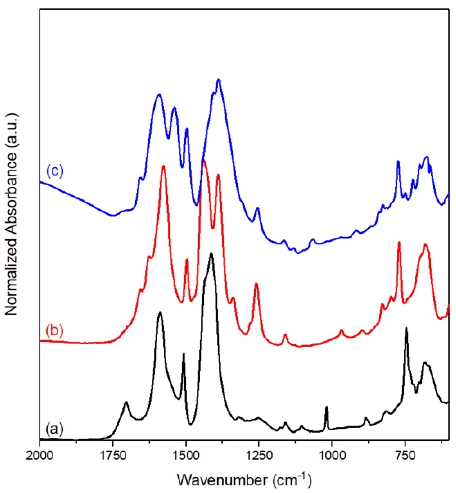
Figure 3. RAIRS of ( a ) UiO-66-H, ( b ) UiO-66-NH 2 and ( c ) UiO-66-NO 2 films.